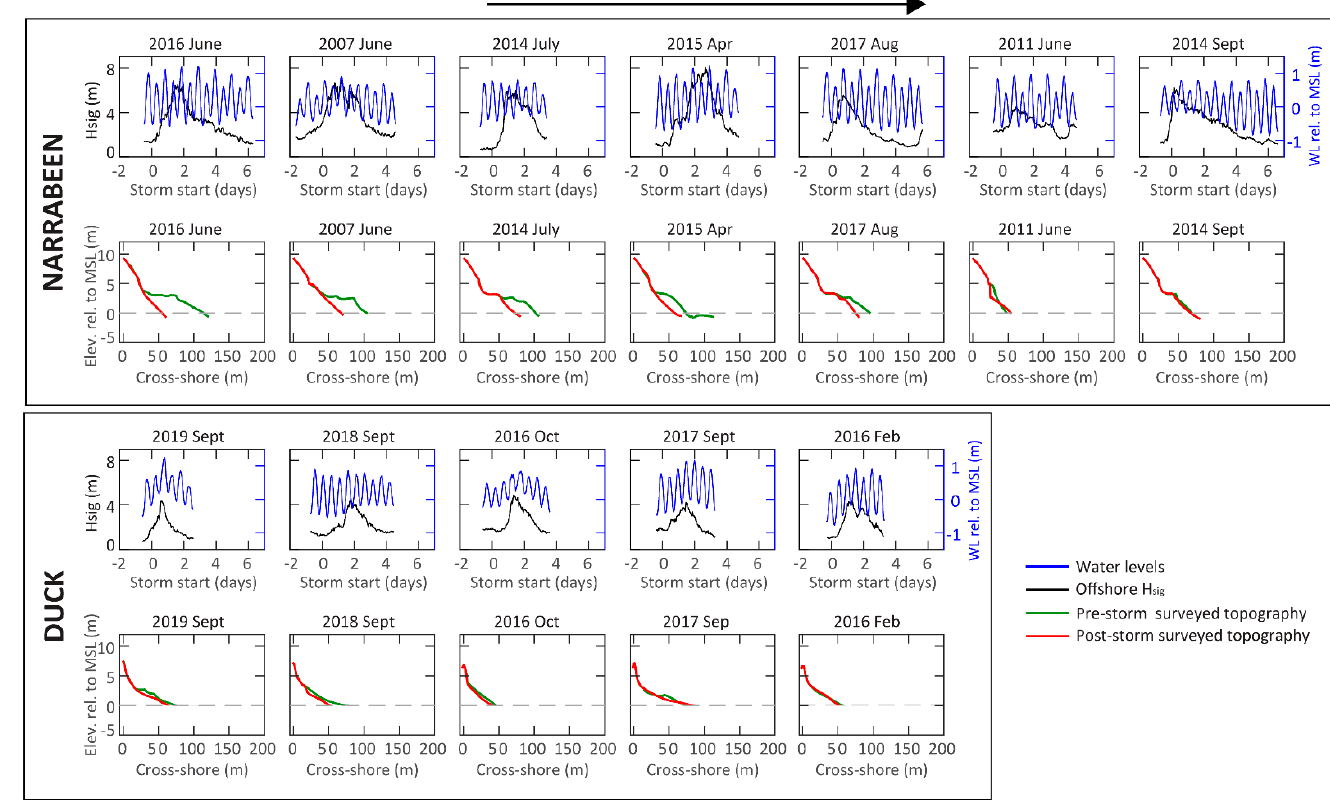
Figure 3. Storm events used for XBeach modelling at Narrabeen (top 2 panels) and Duck (bottom 2 panels). Storms are ordered from left to right in order of increasing observed erosion above the MHHWL for each event. The top panels show the water level (blue) and the significant wave height (black) during that event. The pre- (green) and post-storm (red) topography for the event are shown in the bottom panel for each site. Table 1. Summary of all storm events modelled in this study and the surveyed datasets available for these events. Pre- Storm Surveyed bathymetry is available only for a limited number of storms at Narrabeen. Storm events where these data are not available have been left blank. The three storms used for model calibration at each site are highlighted in grey.